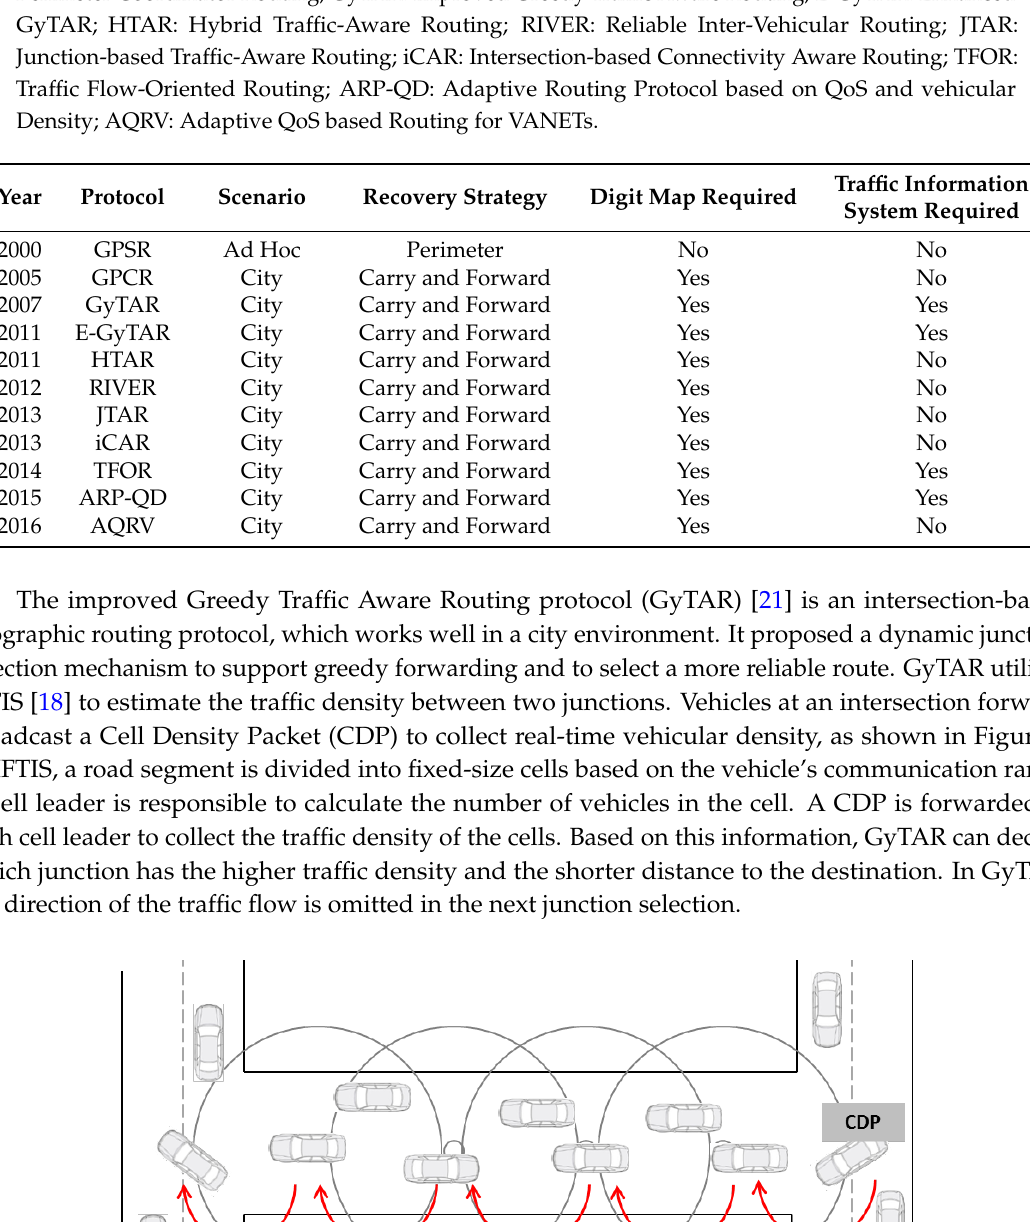
Table 1. Geographic routing protocols, GPSR: Greedy Perimeter Stateless Routing; GPCR: Greedy Perimeter Coordinator Routing; GyTAR: improved Greedy Traffic Aware Routing; E-GyTAR: Enhanced GyTAR; HTAR: Hybrid Traffic-Aware Routing; RIVER: Reliable Inter-Vehicular Routing; JTAR: Junction-based Traffic-Aware Routing; iCAR: Intersection-based Connectivity Aware Routing; TFOR: